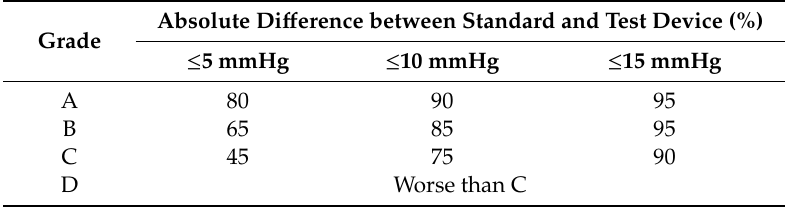
Table 2. British Hypertension Society blood pressure measurement grading system.